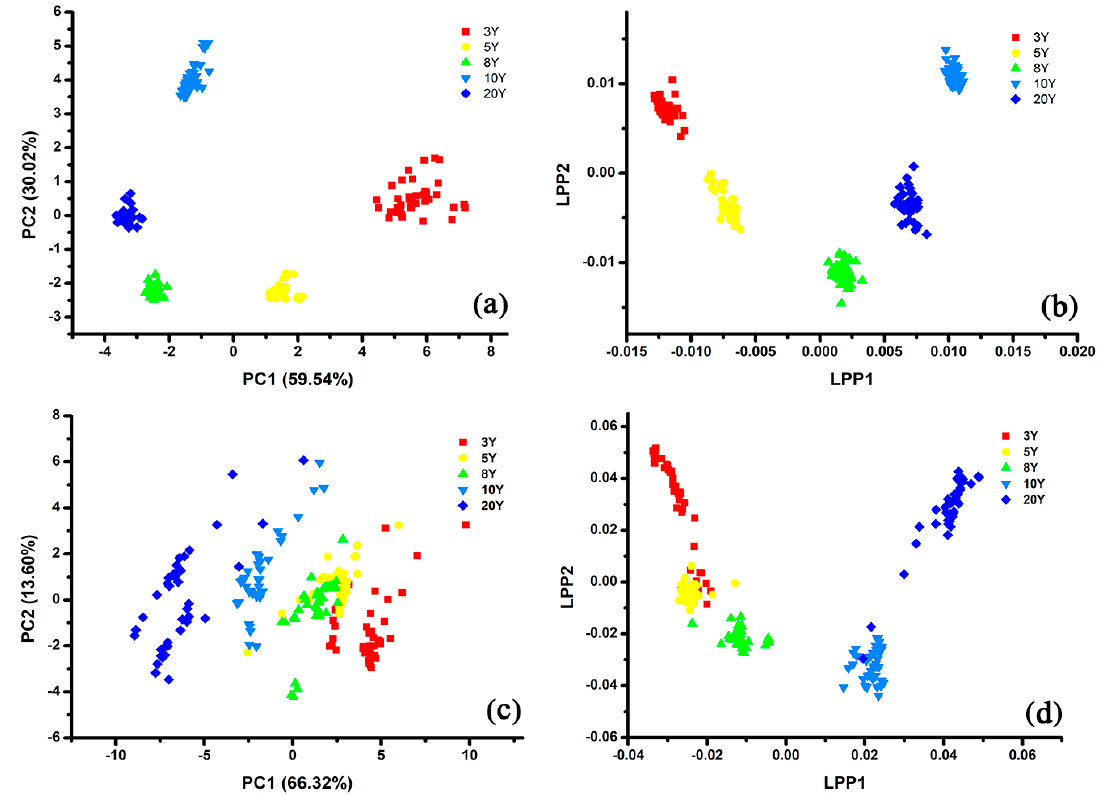
Figure 6. PCA and locality preserving projections (LPP) plots of rice wine samples with different ages (GY-3Y, GY-5Y, GY-8Y, GY-10Y, and GY-20Y) based on original feature data (( a , b ) for e-tongue, ( c , d ) for e-nose).